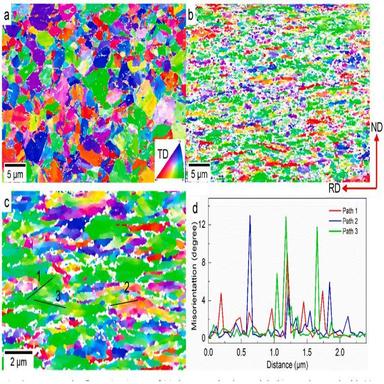
Inverse polar figure (IPF) map of (a) the as-received material, (b) sample tested with 90 J energy and (c) magnified IPF map of the tested sample. Non-indexed areas are marked with white. (d) Misorientation profiles along the black lines drawn in (c).